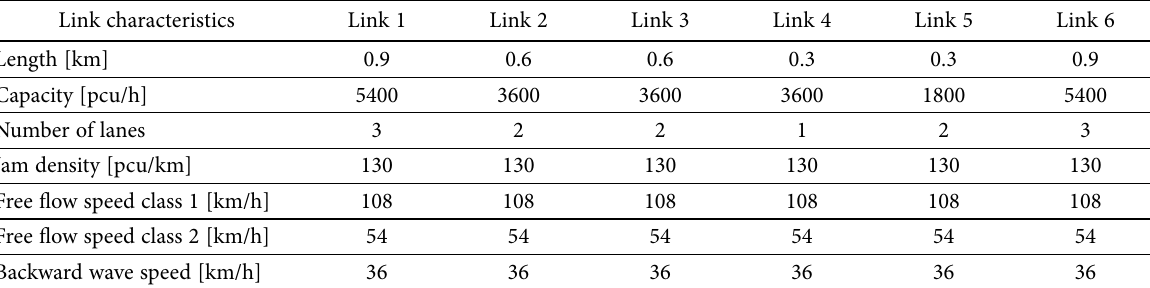
Table 2. Network characteristics